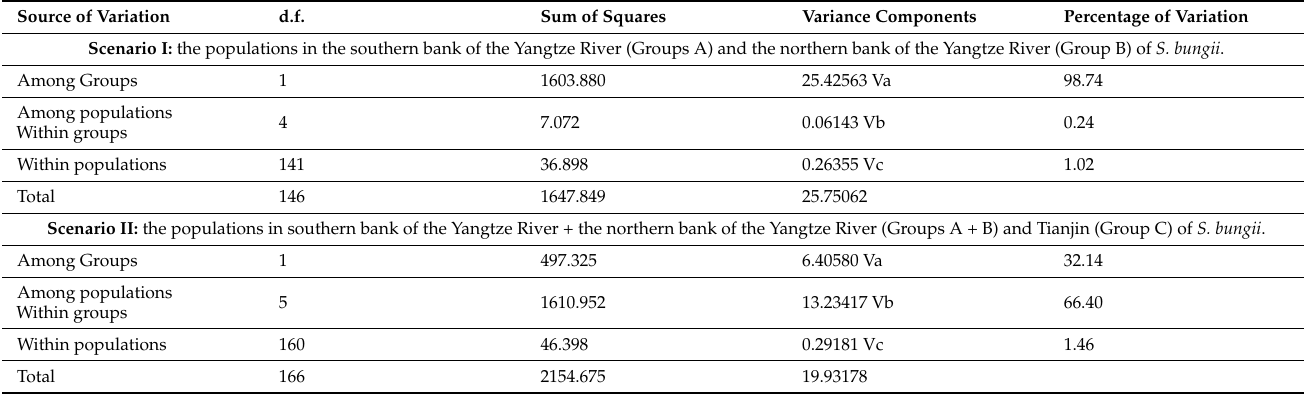
Table 3. Analysis of molecular variance (AMOVA) for S. bungii populations based on mtDNA